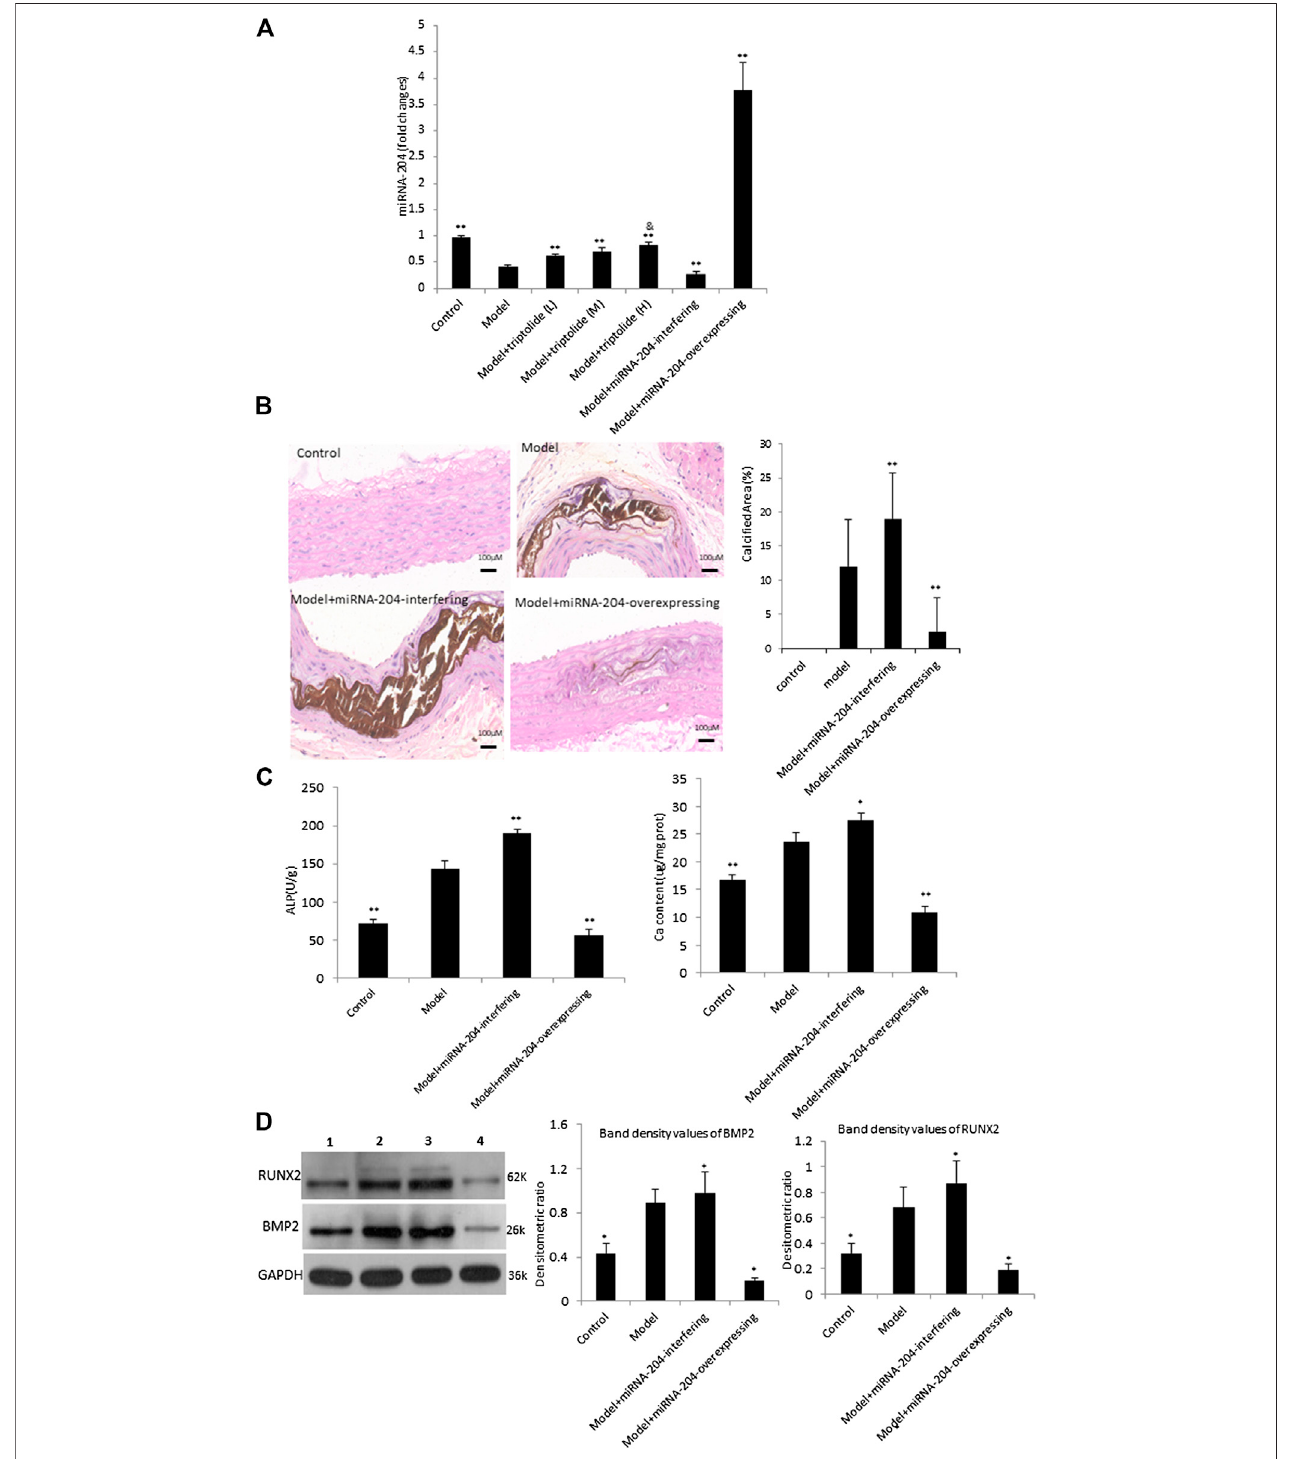
FIGURE3| miRNA-204disturbsvascularcalci fi cationinducedbyVDN (A) RealtimePCRshowedtheexpressionofthemiRNA-204inthedifferentgroups(n (cid:2) 10). ** p < 0.01 compared with model, & p < 0.05 compared with model +TP-L (B) Left: von Kossa staining shows calcium deposition inaortasof rats, right: bar graphs show quantitative evaluation ofthe vonkossa calcium area (n (cid:2) 10). ** p < 0.01 compared with model group (C) Bar graphs show quantitative evaluation of the ALP activity and calcium content. * p < 0.05, ** p < 0.01 compared with model (D) Western blot analysis of BMP2 and RUNX2. Left: representative images of BMP2 and RUNX2 expression, an antibody for DAPDH was used to show equal protein loading (lane 1: Control, lane 2: Model, lane 3: Model + miRNA-204-interfering, lane 4: Model + miRNA-204-overexpression); Right: bar graphs show quantitative evaluation of BMP2 and RUNX2 expression (n (cid:2) 3). Data are reported as the mean ± S.D, * p < 0.05 compared with model